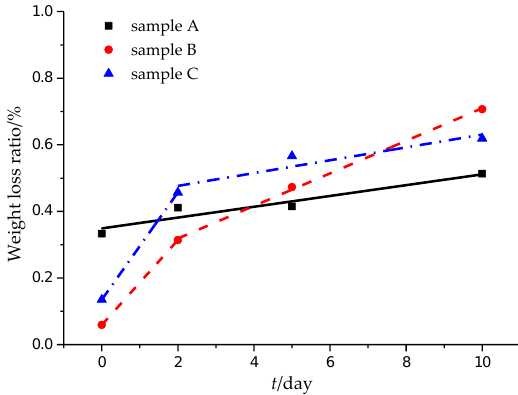
Figure 11. Comparison chart of the weight loss ratio trends of three kinds of Mg/TeO 2 ignition composition after 180 °C storage test.